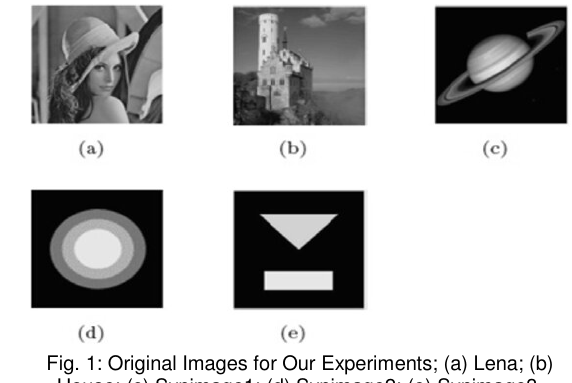
Fig. 1: Original Images for Our Experiments; (a) Lena; (b) House; (c) Synimage1; (d) Synimage2; (e) Synimage3. where indicates the true image, z is the denoised z(cid:136) image, and m × n represents the image size. The stopping criteria for iterations in the proposed scheme is given by the following condition.